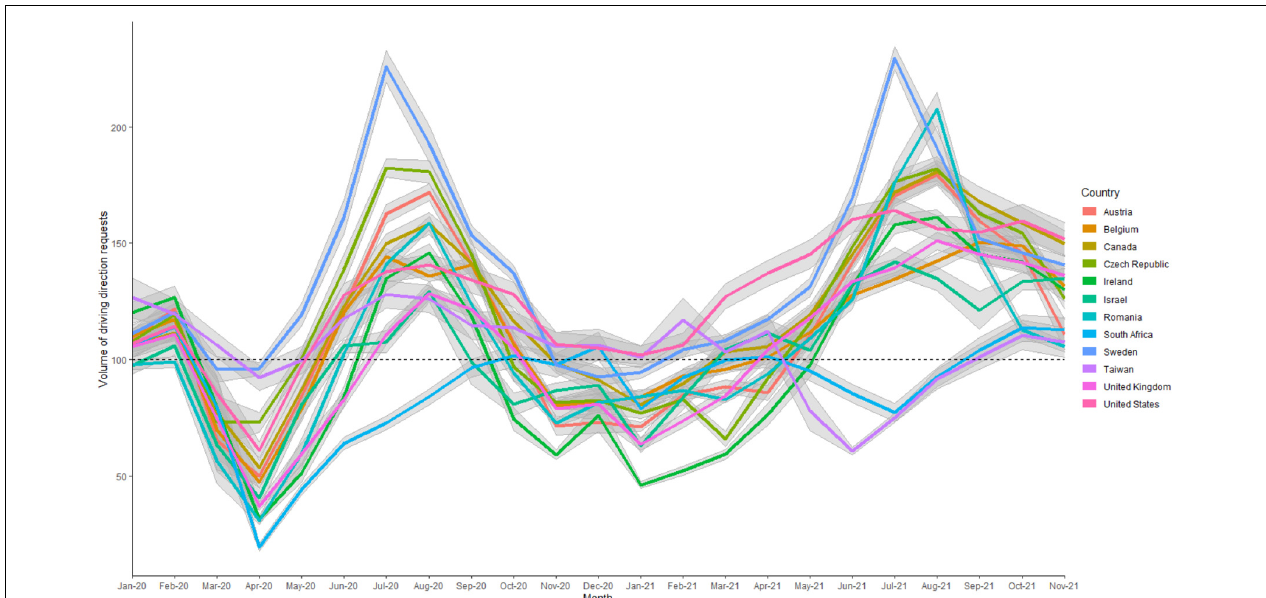
FIGURE 1 | Country-specific changes in monthly mean aggregated requests for directions in Apple maps, representing a proxy for traffic activity during the SARS CoV-2 pandemic in 2020/21 relative to a baseline “norm” on 13th Jan 2020. Countries with data shown are those with National WVC schemes (after Shilling et al., 2020). Data source; https://covid19.apple.com/mobility.